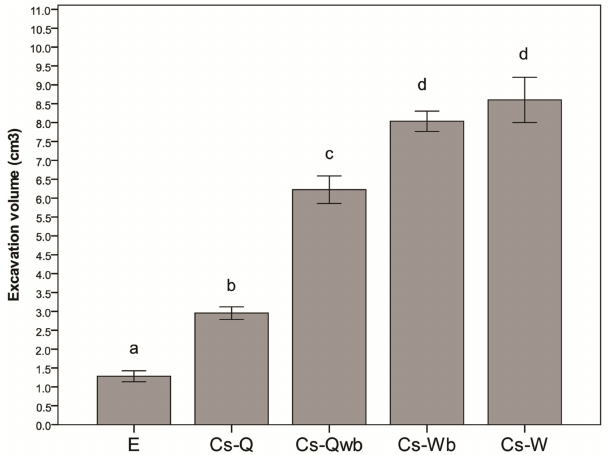
Figure 8. Excavation volume in galls colonized by Cr. scutellaris according to colony composition: E = empty, Cs-Q = Cr. scutellaris queen only, Cs-Qwb = Cr. scutellaris queen + workers + brood, Cs-Wb = Cr. scutellaris workers + brood, Cs-W = Cr. scutellaris workers only. The SE interval is shown for each bar. The bars with the same letter are not statistically di ff erent (One-way ANOVA, see text for further